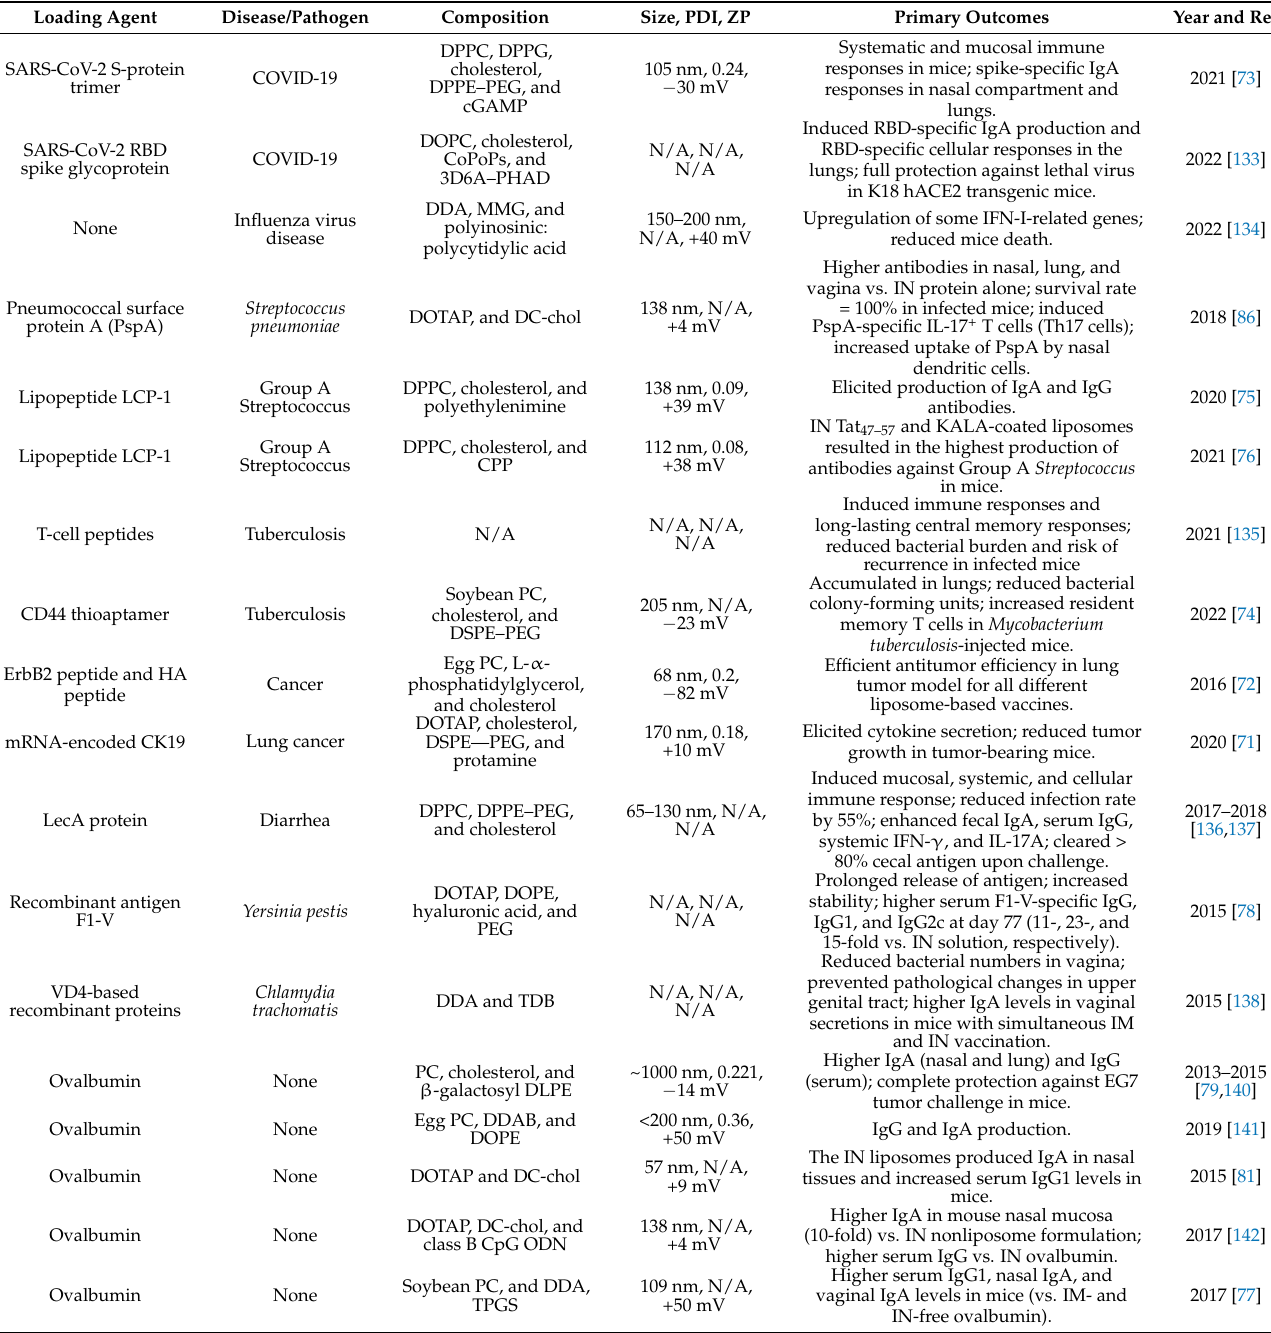
Table 3. Major features of intranasal liposomes for vaccine